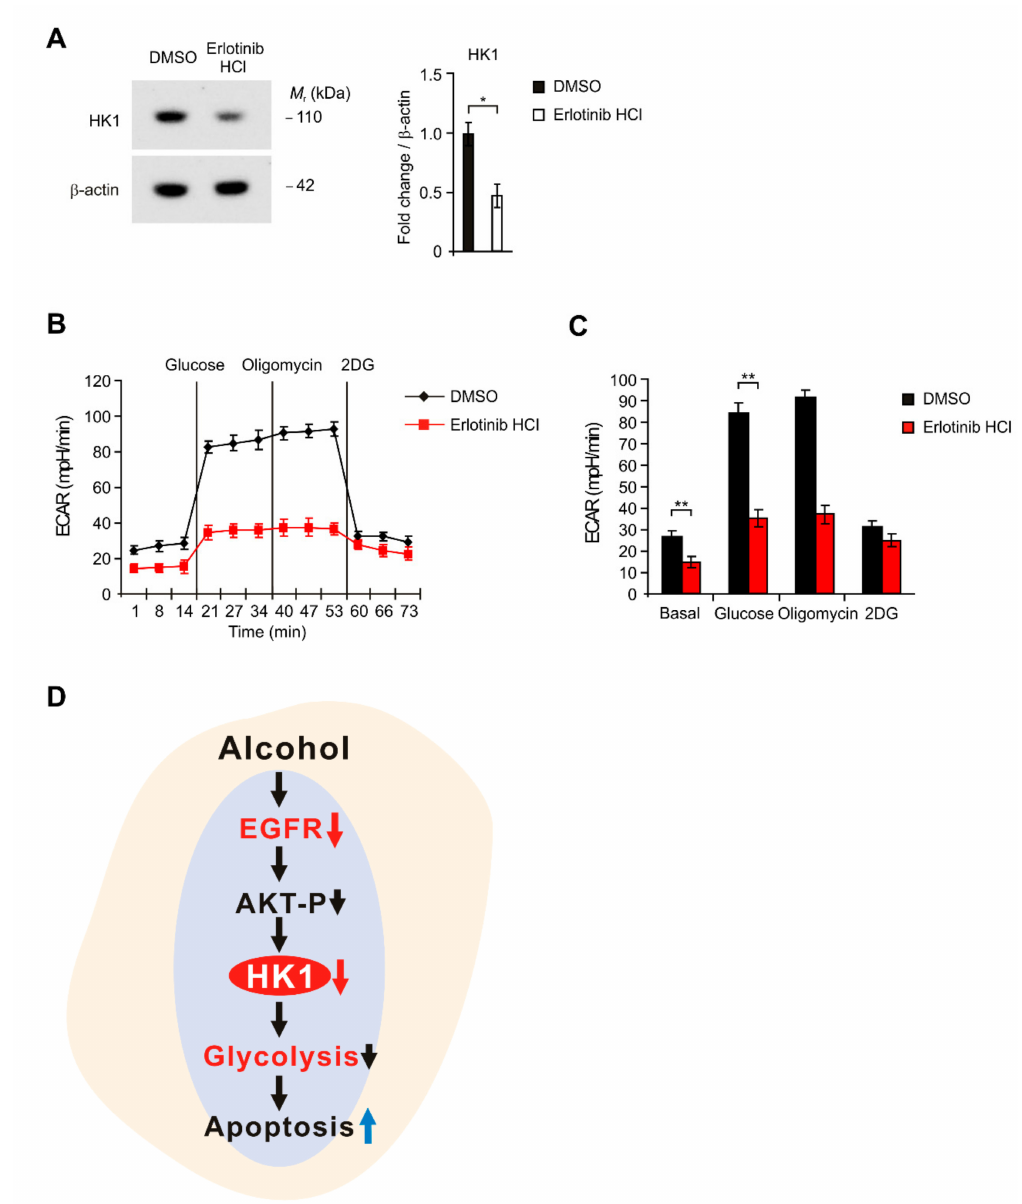
Figure5. InhibitionofEGFRsuppressesHK1-dependentglycolysisinHEI-OC1cells. ( A )Representative immunoblot analysis for HK1 ( left ) and quantification for HK1 protein levels ( right ) from HEI-OC1 cells treated with Erlotinib HCl (Erlotinib, 5 µ M) or control (DMSO) for 4h. For immunoblots, β -actin was used as loading control. Data are representative of three independent experiments. Data are mean ± SEM. * p < 0.05 using the two-tailed Student’s t -test. ( B ) The levels of extracellular acidification rate (ECAR) for glycolysis of glucose and ( C ) quantification of ECAR levels from HEI-OC1 cells treated with Erlotinib HCl (Erlotinib, 5 µ M) or control (DMSO) for 4 h. Data are representative of three independent experiments. Data are mean ± SEM. ** p < 0.01 using the two-tailed Student’s t-test. ( D ) The schematic diagram to summary of our new